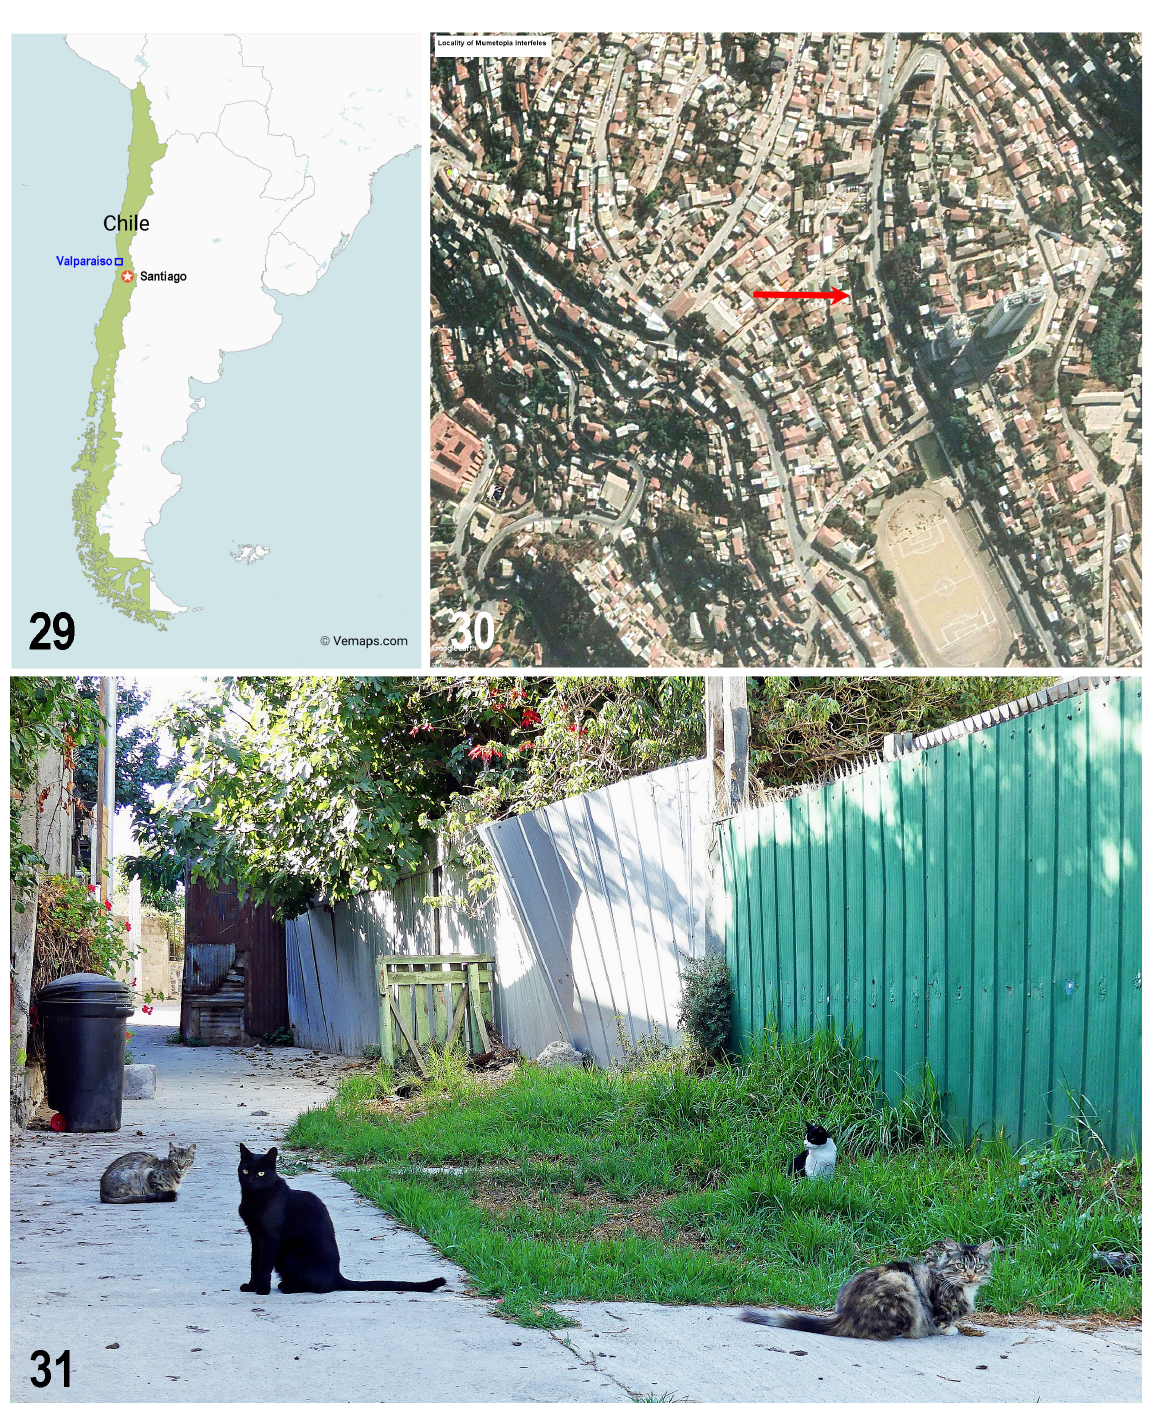
Figs 29–31. Maps and habitat. 29 . Map of Chile with position of type locality of Mumetopia interfeles Roháček sp. nov. (blue open square). 30 . Satellite view of part of Valparaíso city, with collecting site indicated by red arrow. 31 . Habitat of M. interfeles sp. nov., northern end of grassy area between houses visited by cats. Photo by J. von Tschirnhaus (31), other sources: Vemaps.com (29), Google Earth Pro